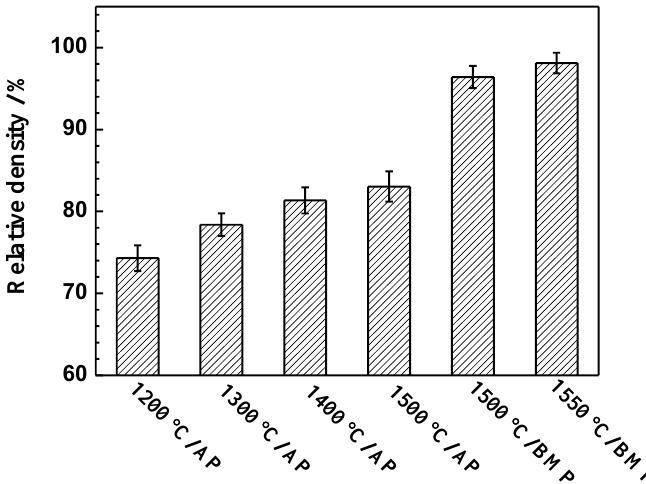
Figure 3. Relative density of Ti-28Nb-35.4Zr alloy prepared with different sintering temperatures and powders.